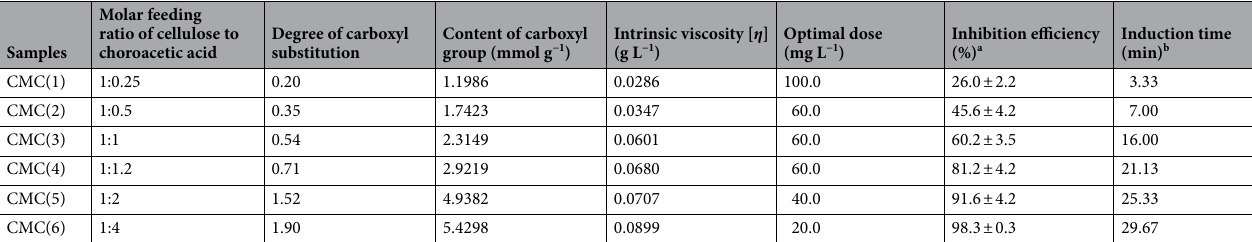
Table 1. Summary of the preparation conditions, structural parameters and the scale-inhibition performance of various CMC samples with different degrees of carboxyl substitution against CaCO 3 scales based on static tests and crystallization process. a Scale-inhibition efficiencies of various CMC samples in static test, at their optimal doses; b The induction time was obtained in the presence of 2.0 mg L −1 CMC.